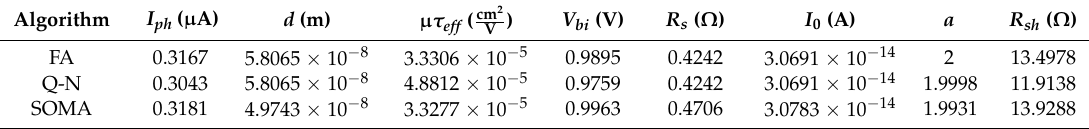
Table 9. Comparison among different parameter extraction of flexile silicon a-Si:H solar cell.